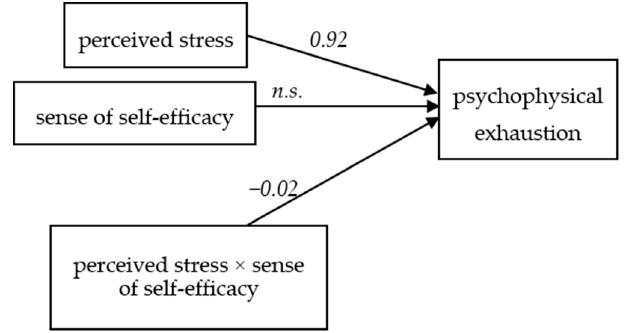
Figure 2. The model of relations between the perceived stress and psychophysical exhaustion, moderated by the sense of self-efficacy ( n.s. : not significant).